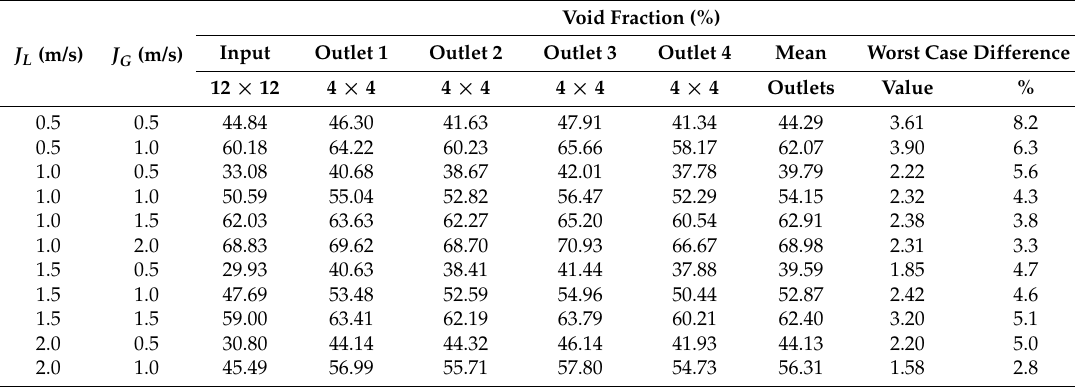
Table 2. Summary of mean void fraction results.